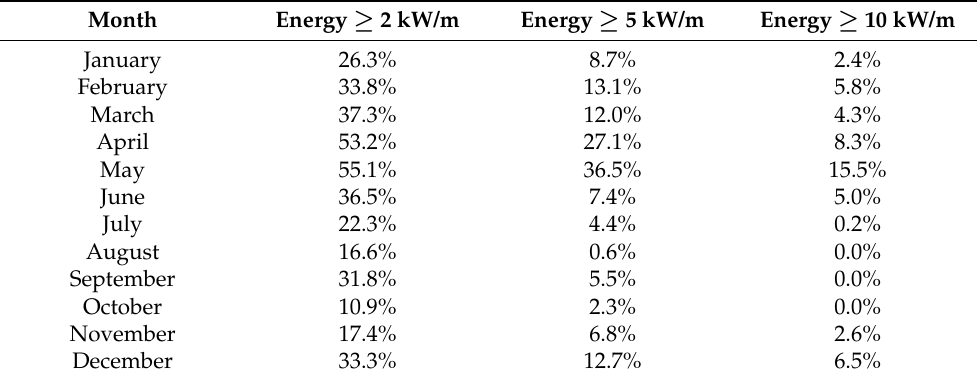
Table 3. Percentages of days in which the energy is equal to or greater than the energy thresholds: ≥ 2 kW/m, ≥ 5 kW/m, ≥ 10 kW/m. Values are averaged over all nodes and for each month of the TMY.